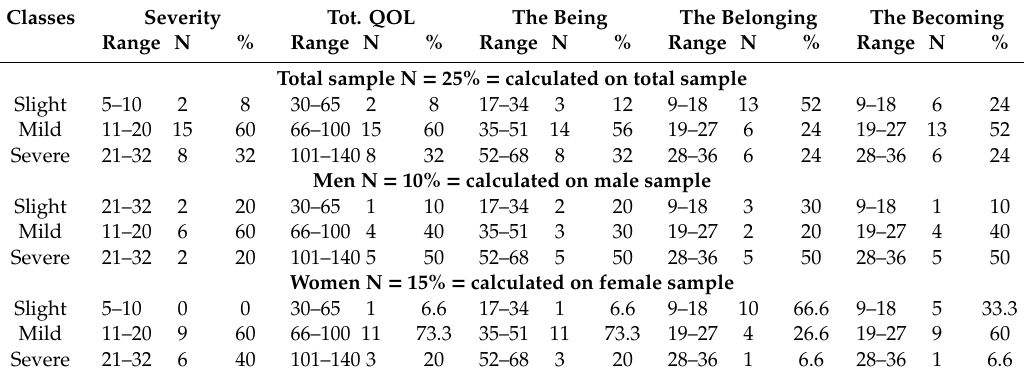
Figure 3. This figure shows the graphic of a linear regression between QOL scores and age in men. Table 5. This table shows the sample numbers and percentages divided into classes.